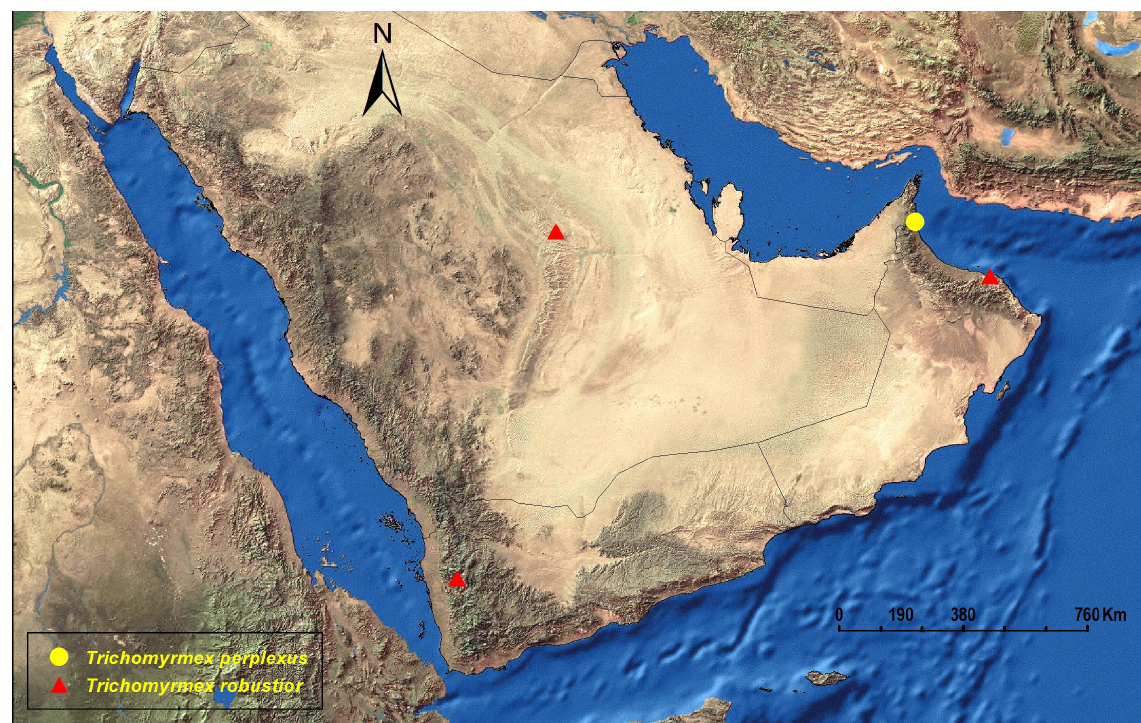
Fig. 17. Distribution map of Trichomyrmex perplexus (Radchenko, 1997) and T. robustior (Forel,